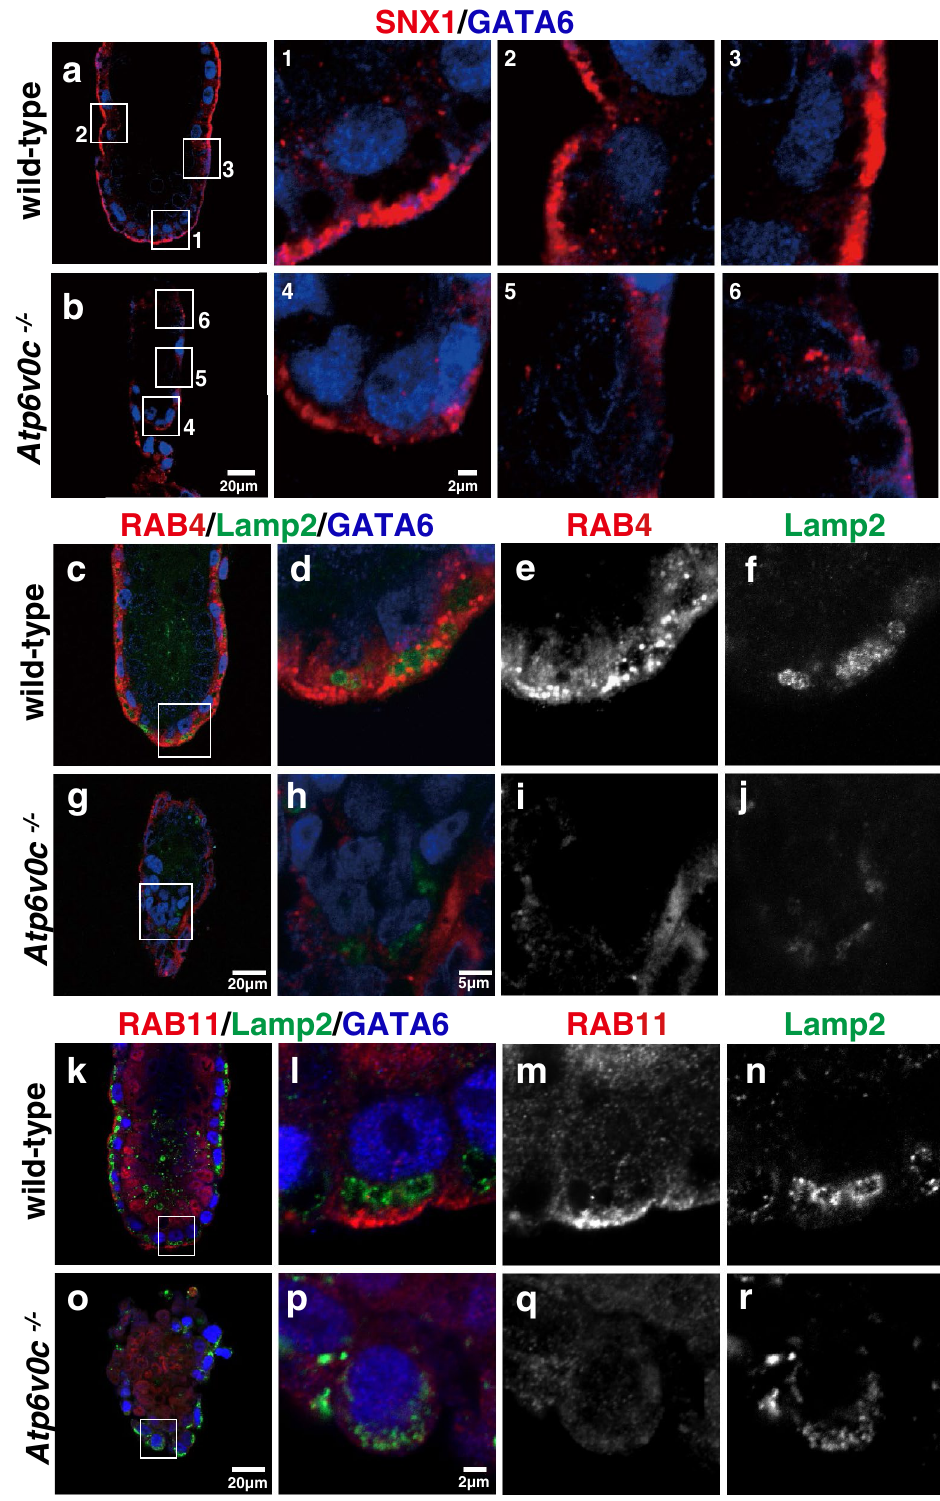
Figure 5. Early endosome/lysosome in VE cells of E5.5 embryos. Localisation of the early endosome marker, SNX1 (red), in wild-type ( a , and boxed regions 1 to 3) (n = 3) and Atp6v0c mutant embryos ( b , and boxed regions 4 to 6) (n = 4). VE cells were labelled with GATA6 (blue). Localisation of the recycling endosome marker, RAB4 (red), and Lamp2 (green) in wild-type ( c–f ) (n = 9) and Atp6v0c mutant embryos (g–j) (n = 4). Localisation of the recycling endosome marker, RAB11 (red), and Lamp2 (green) in wild-type ( k–n ) (n = 18) and Atp6v0c mutant embryos ( o–r ) (n = 13). Scale bars are indicated in each